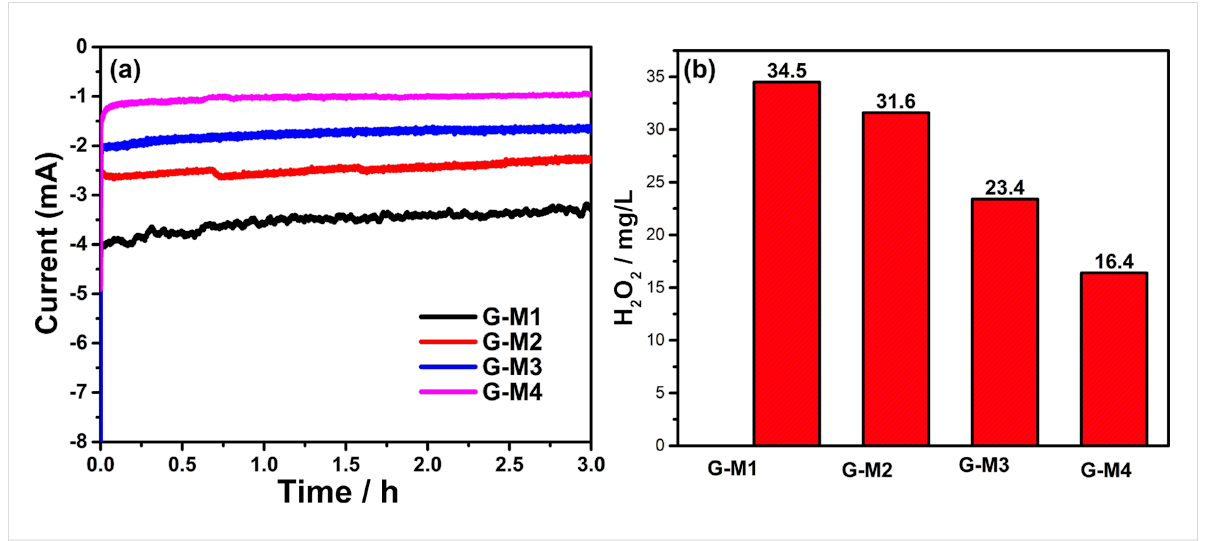
Figure 7: (a) Chronoamperogram of O 2 reduction at 0.358 V on graphite paper modified with EEG. (b) The amount of H 2 O 2 produced by each sam- ple is shown in Figure 7b.